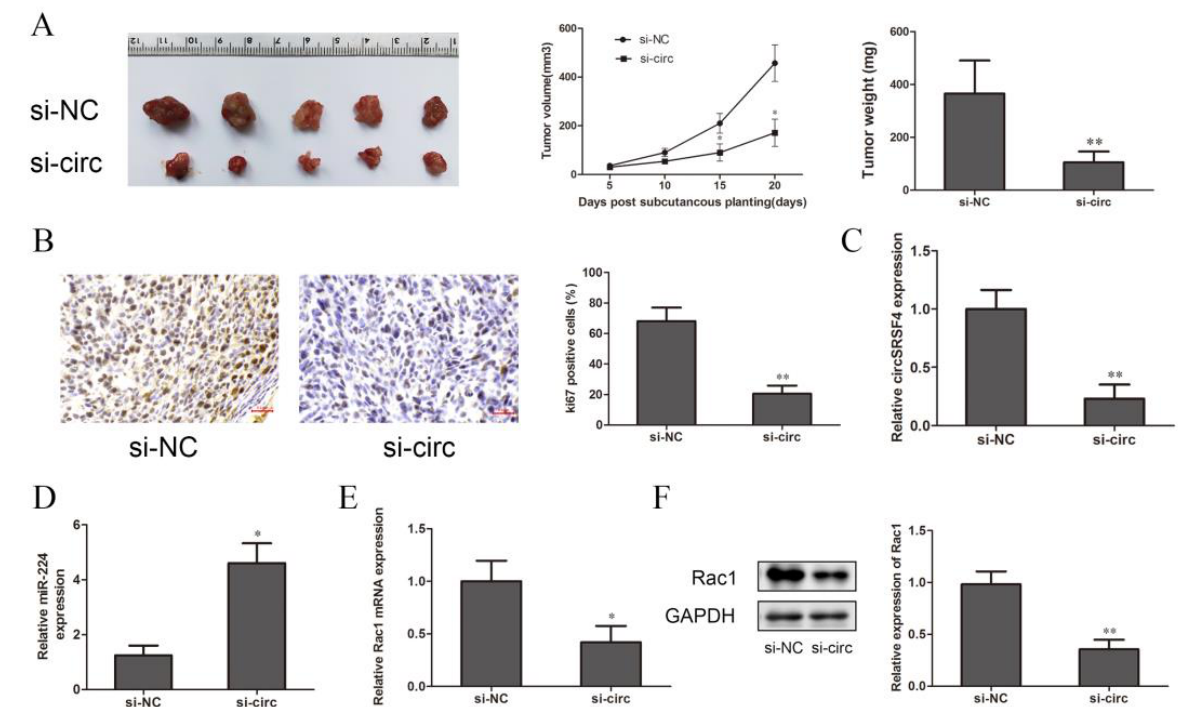
Figure 6. Down-regulation of circSRSF4 inhibits the growth of OS in vivo. (A) After knocking down circSRSF4, the growth of transplanted tumors in nude mice was inhibited. (B) Immunohistochemistry staining of tumor tissues in nude mice. (C) Expression of circSRSF4 in tumor tissues of nude mice. (D) Expression of miR-224 in tumor tissues of nude mice. (E) Expression of Rac1 mRNA in tumor tissues of nude mice. (F) Rac1 protein expression in tumor tissues of nude mice. *P <0.05, ** P <0.01, ***P <0.001.